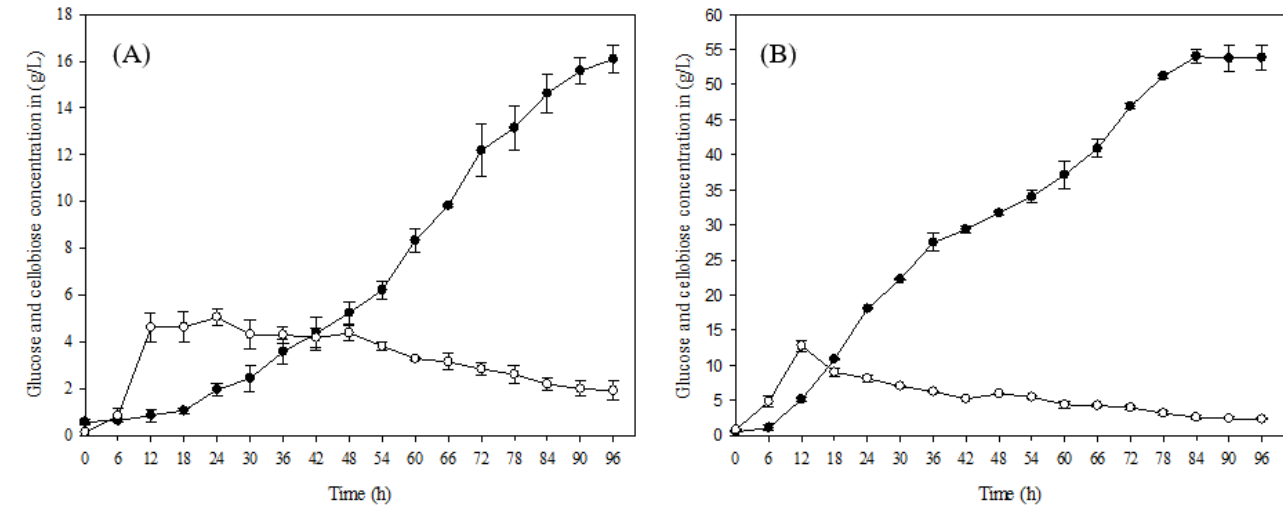
Figure 2. Enzyme hydrolysis of oil palm frond ( A ) before pretreatment (raw material) and ( B ) after pretreatment: (●) glucose concentration and ( ○ ) cellobiose concentration in g/L. pretreatment: ( • ) glucose concentration and